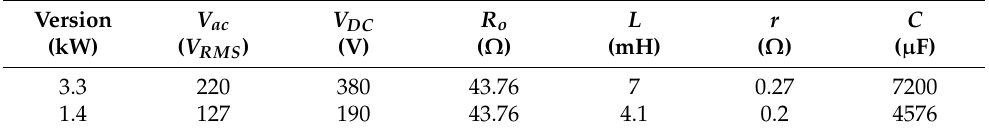
Table 7. Parameter values design for single phase DC–AC full bridge